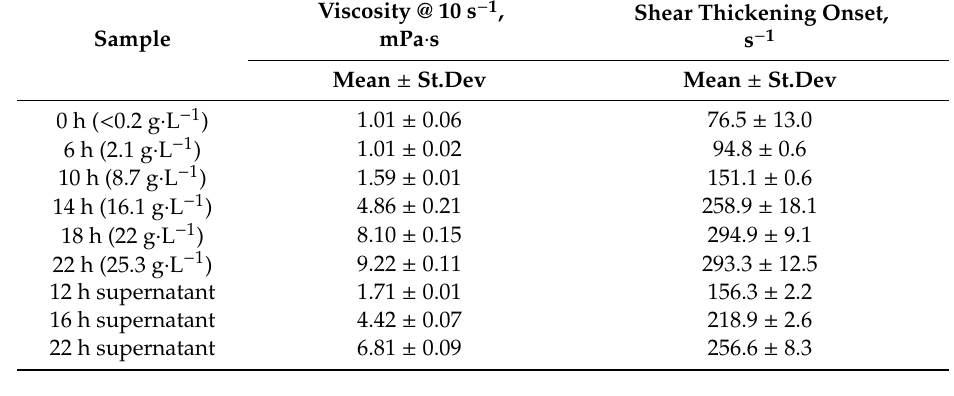
Table 2. Summary of average viscosity at a shearing rate of 10 rad·s − 1 and onset of shear-thickening ( n = 3)